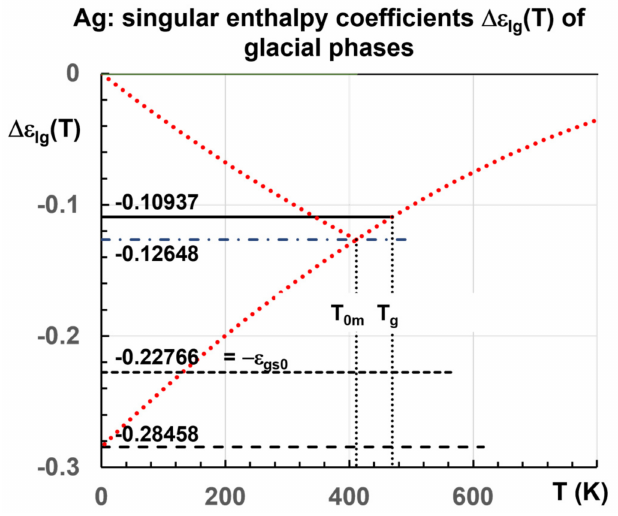
Figure 4. Enthalpy coefficients of Ag Phase 3 versus Temperature in Kelvins with singular values. Table 1. Lindemann coefficients δ ls , singular values of enthalpy coefficients − ε ls0 = − ε gs0 , ∆ ε lg ( θ 0m ), − 1.25 ε ls0 , ∆ ε lg ( θ g ), being fractions of melting enthalpy of liquid elements. All elements, in the same column of Figure 1, have identical singular enthalpy coefficients. T m , T g and T D are in